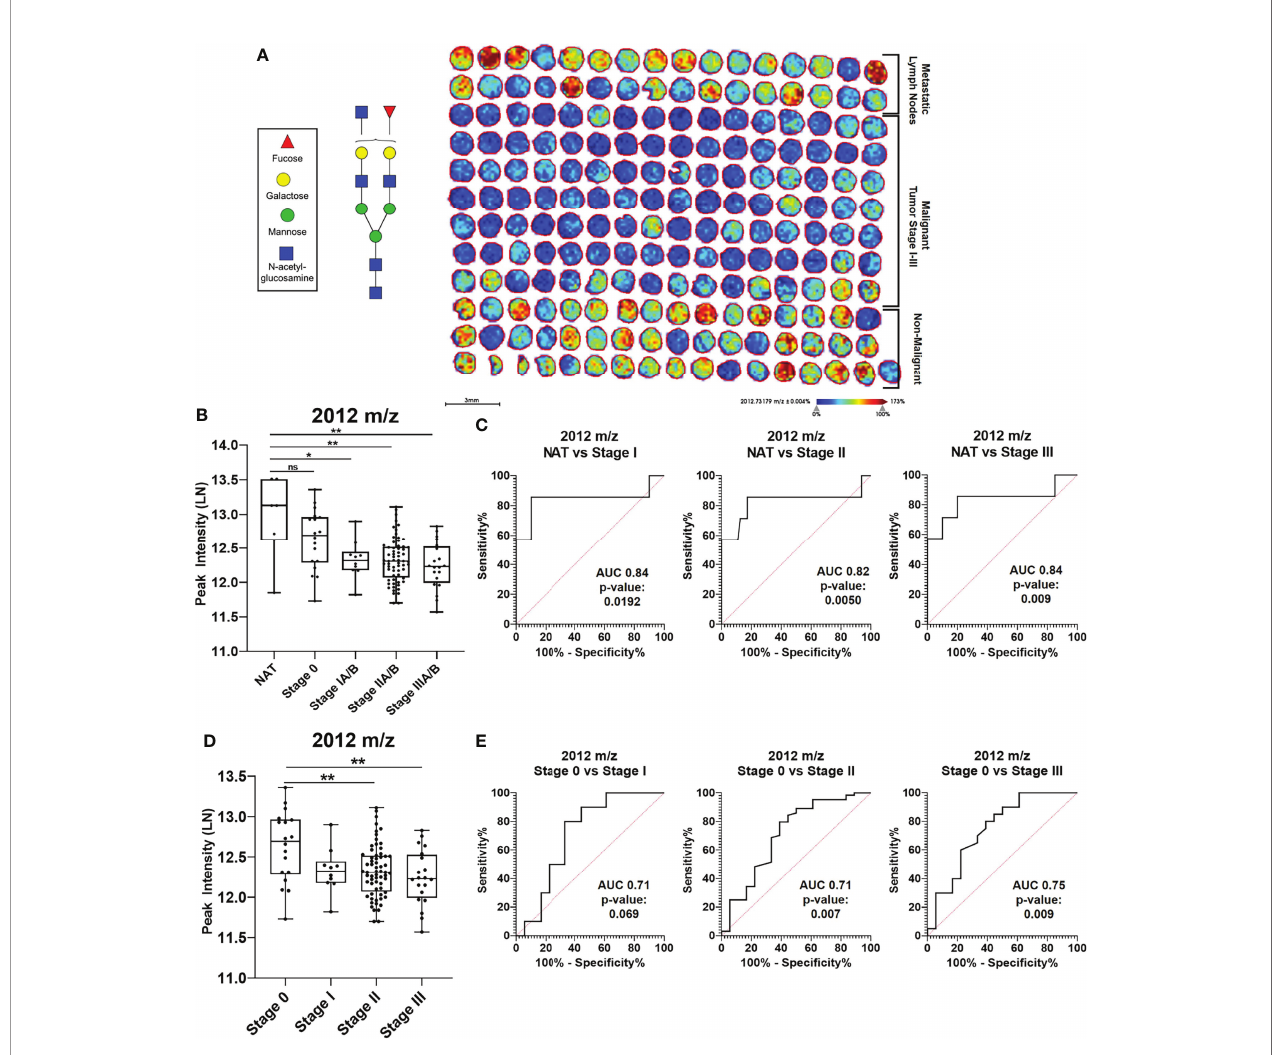
FIGURE 5 | N-glycan 2012 m/z has speci fi c intensify patterns in breast cancer progression. (A) Imaging peak intensify heat map of breast cancer progression TMAS for 2012 m/z in Benign, In fl ammation, Hyperplasia, normal adjacent to the tumor (NAT), Adjacent to the tumor (AT), Stages 0-III, and Metastatic Lymp TMA cores. (B) Mann Whitney analysis of N-glycan peak 2012 m/z comparing intensi fi es between Normal Adjacent to the Tumor (NAT) and malignant cores Stages 0-III (* = p-value<0.05; ** =p-value <0.01). (C) ROC curve analysis for peak. 2012 m/z looking at NAT vs Stage IIIA/B (ROC AUC 0.847, p-value 0.009). (D) Mann Whitney analysis of N-glycan peak 2012 m/z comparing intensi fi es between Stages 0-III (** = p- value <0.01). (E) ROC curve analysis for peak 2012 m/z looking at Stage 0 vs stage IA/B (ROC AUC 0.71, p- value 0.069), Stage 0 vs Stage IIA/b (ROC AUC 0.75, p-value 0.009). NS, Not Statistically Signi fi